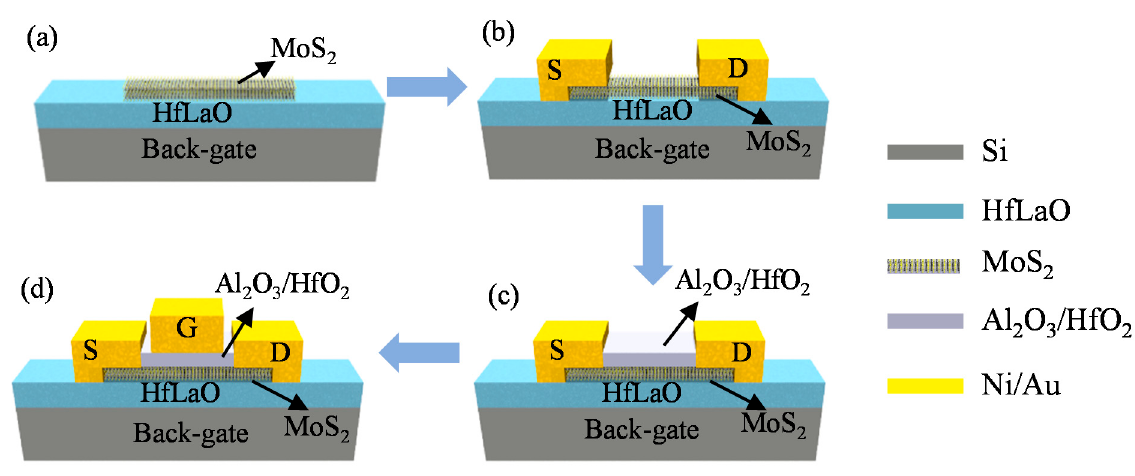
Figure 1. Process for fabricating the dual-gate MoS 2 field-effect transistors. ( a ) Bilayer MoS 2 is first transferred on HfLaO/Si substrates. ( b ) Source and drain contact metal deposition. ( c ) Top-gate dielectrics of Al 2 O 3 /HfO 2 deposition. ( d ) Top-gate metal pattern and deposition. S: source, D: drain, G: gate.